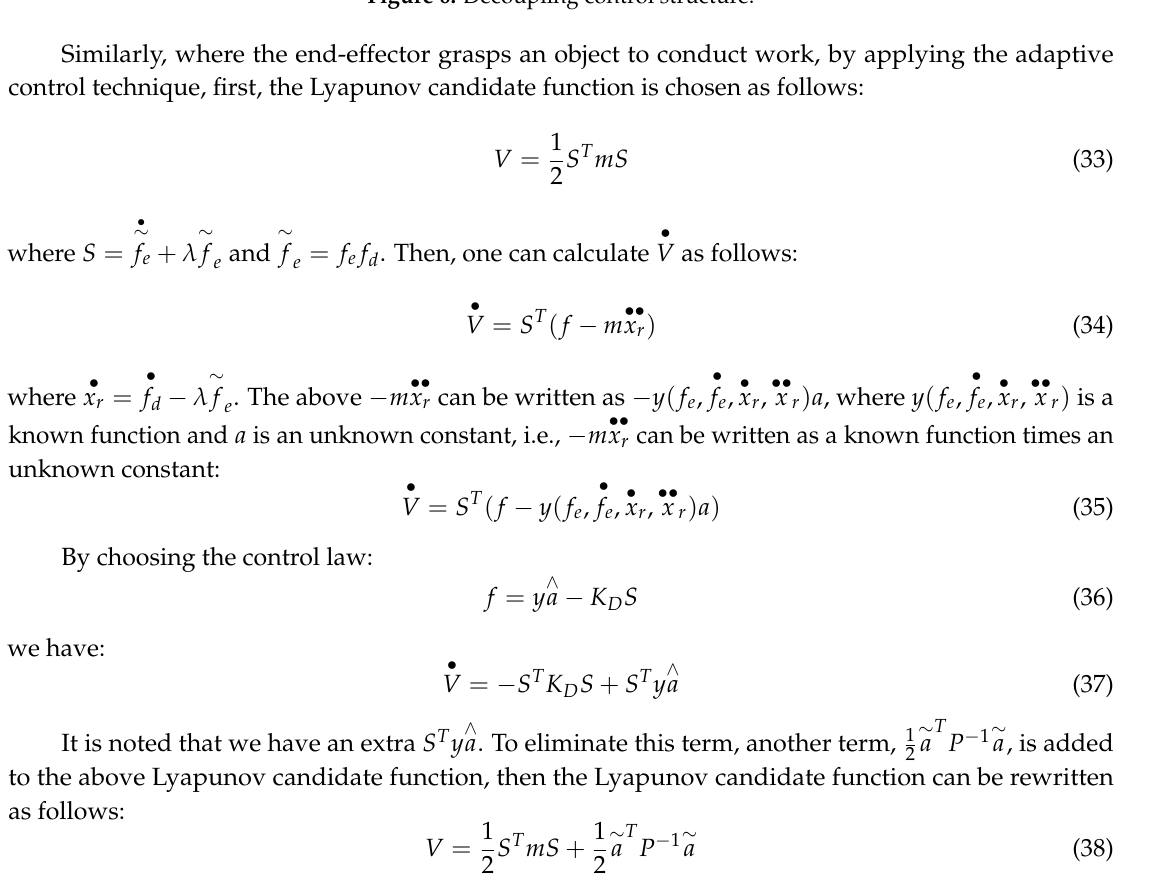
Figure 6. Decoupling control